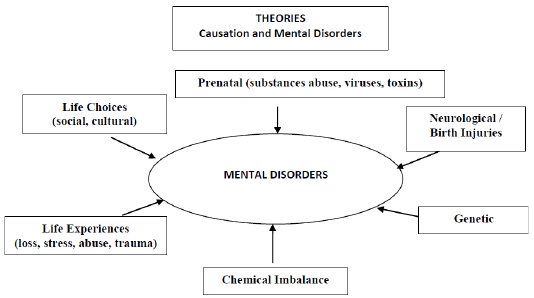
Figure 1. Theories of Causation and Mental Disorders